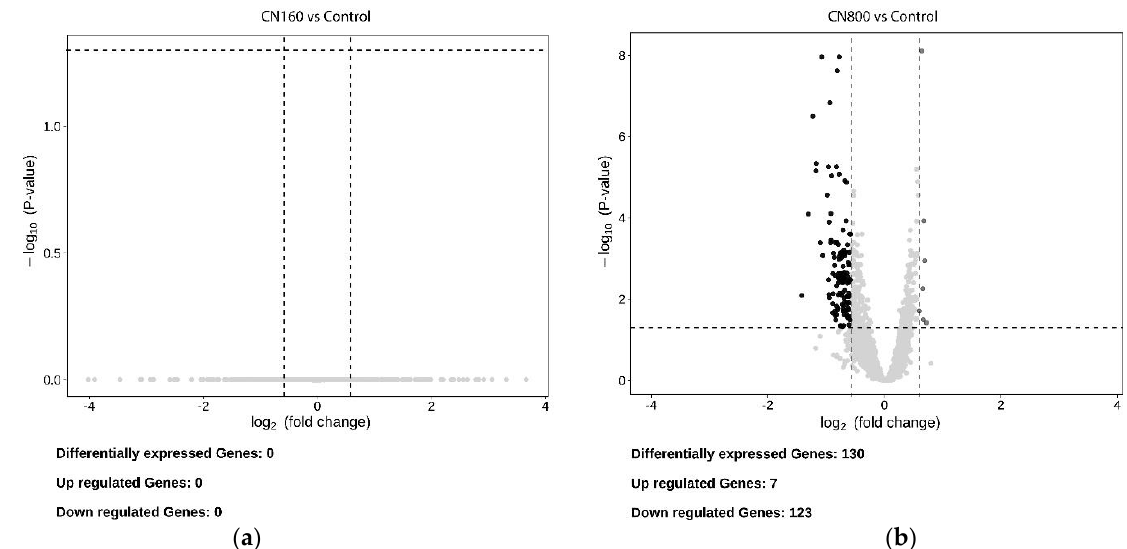
Figure 6. Volcano plots displaying the fold change (log2) of differentially expressed genes of the two conditions, ( a ) CN160 and ( b ) CN800 versus the control. The genes were considered significantly differentially expressed if they had a fold change higher than 1.5 (upregulated) or lower than 1/1.5 (downregulated), and an FDR lower than 0.05.